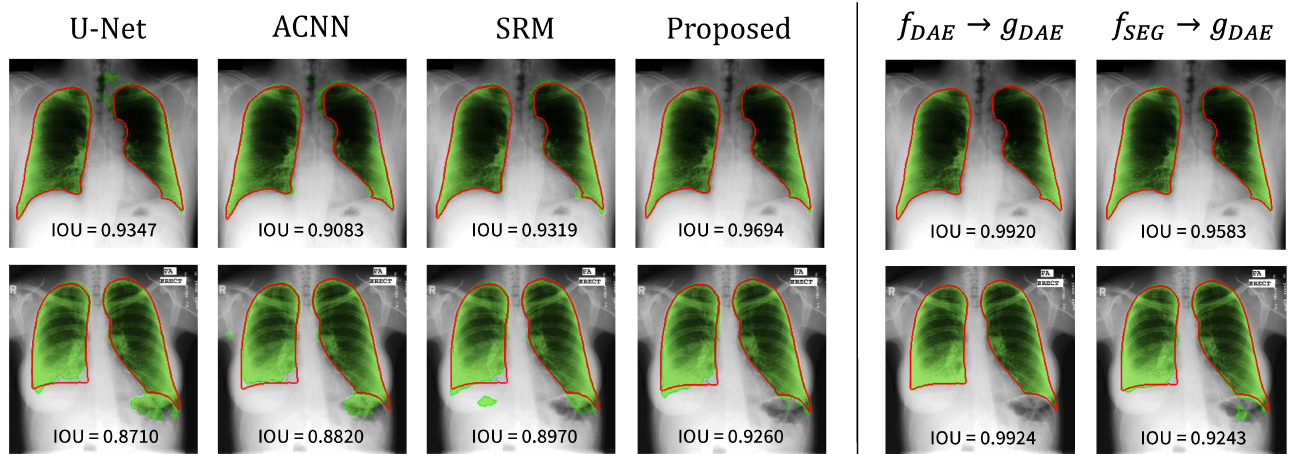
Figure 4. Visualization of the lung segmentation results on test samples from JSRT ( top ) and MC ( bottom ). The left part shows the results of each method, and the right part presents the results from f DAE → g DAE and f SEG → g DAE of the proposed method. The green color represents the segmentation results of each method, and the ground-truth is in